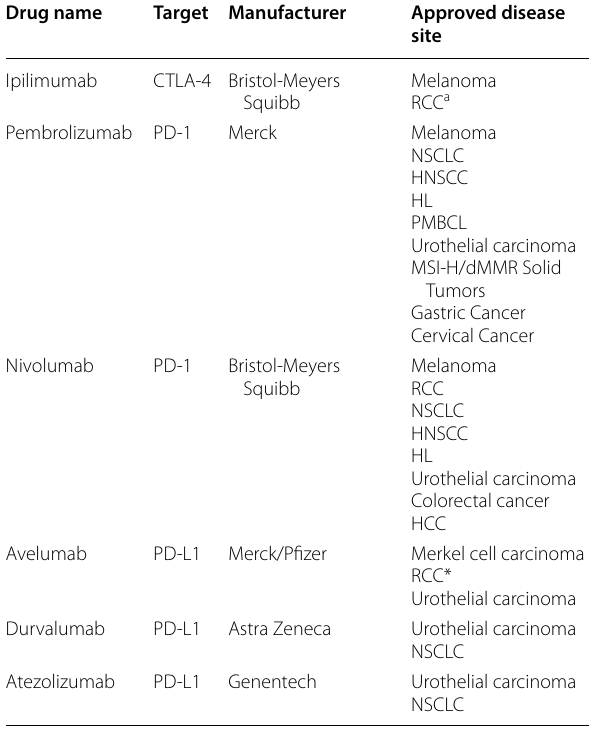
Table 1 Currently approved checkpoint